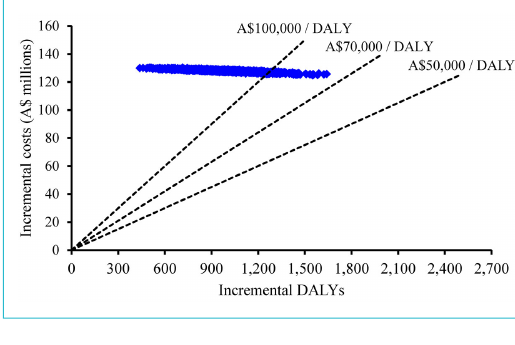
Figure 3: The cost-effectiveness plane. DALY = disability-adjusted life-year.